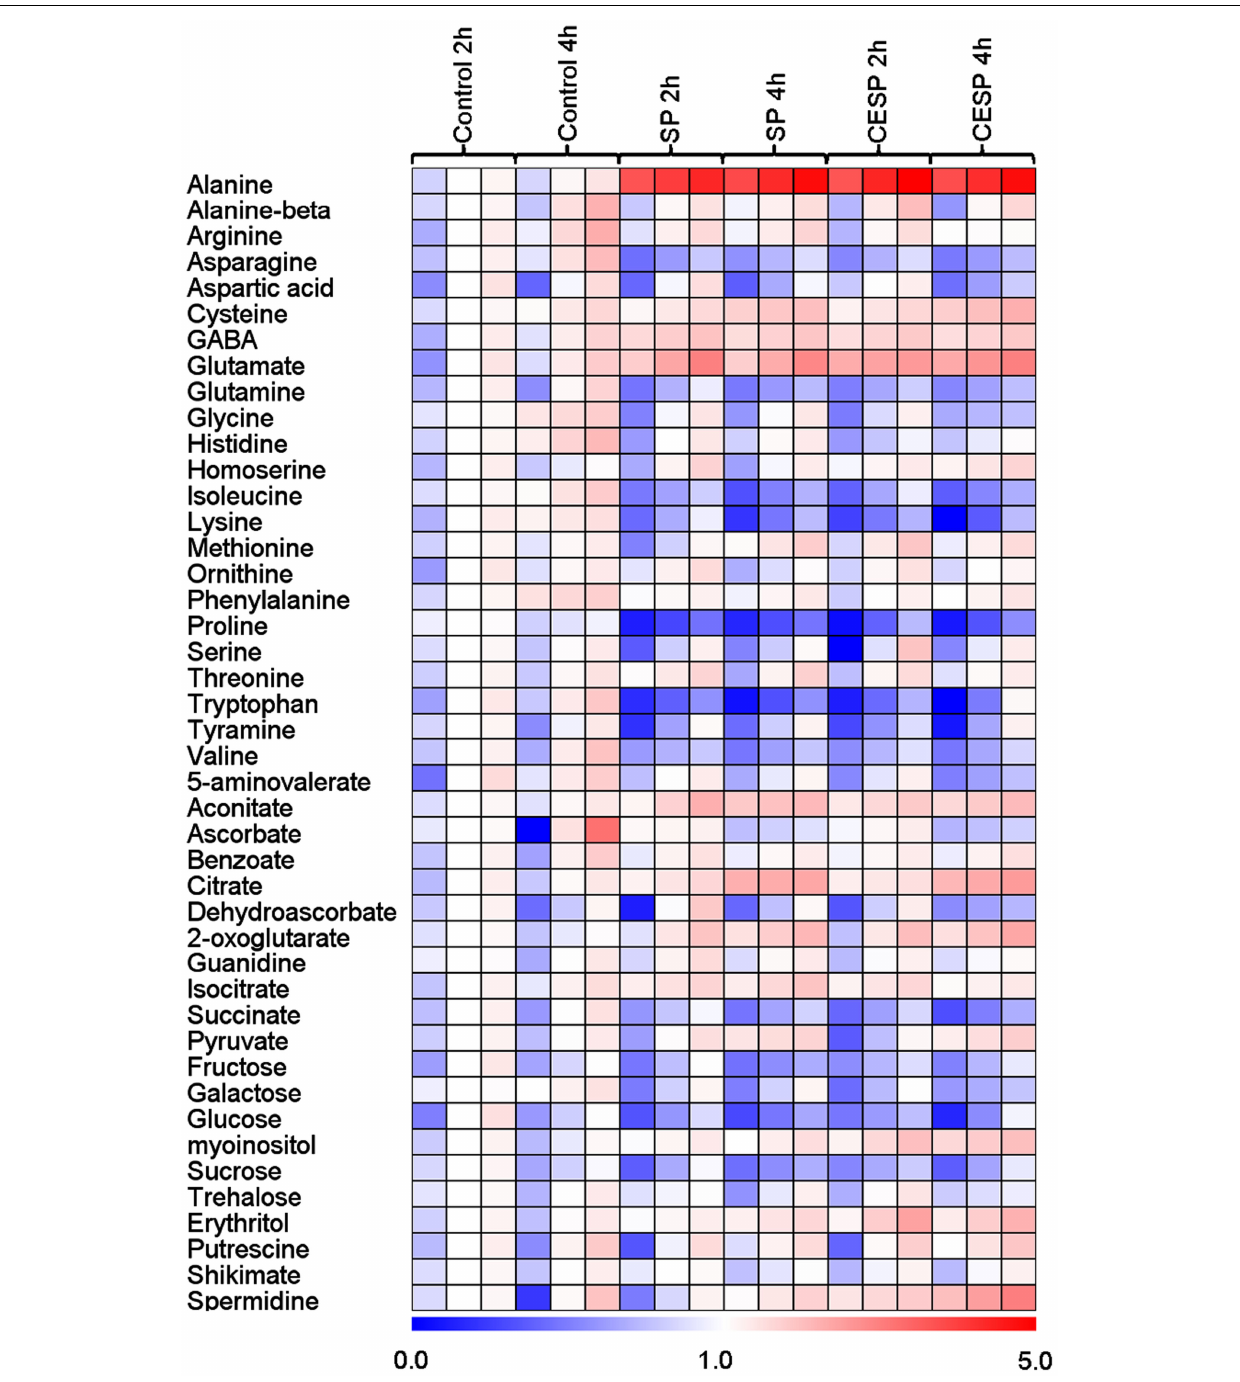
FIGURE 4 | Heat map representing the changes in relative metabolite contents of treated and control Arabidopsis leaf disks. Leaf disks were cut directly from 4-week-old plants, washed three times with 10mM MES-KOH (pH 6.5), and then incubated during up to 4h in 10mM MES-KOH buffer (pH 6.5) containing 2.0mM glucose and 100 μ M of SP or CESP. Metabolites were determined as described in the Section “Materials and